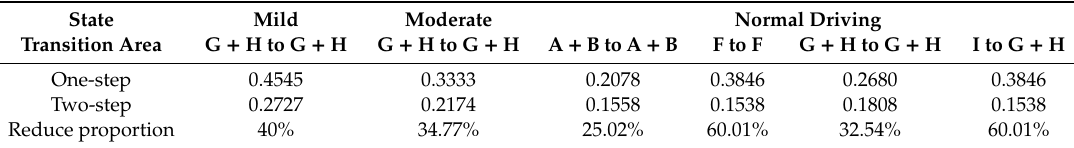
Table 8. Description with significantly reduced under di ff erent